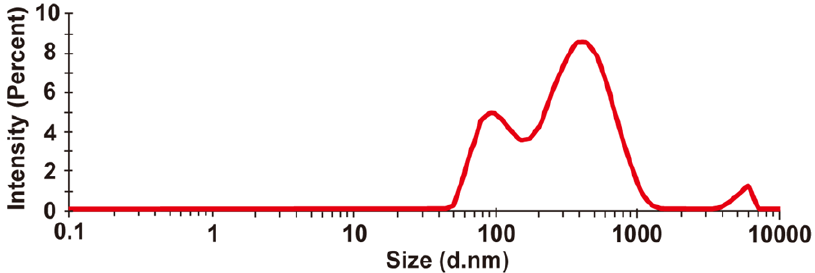
Figure 2. DLS analysis of 1.69 mM PRS extracts in phosphate buffered saline solution (pH 7.4, 0.1 mM).